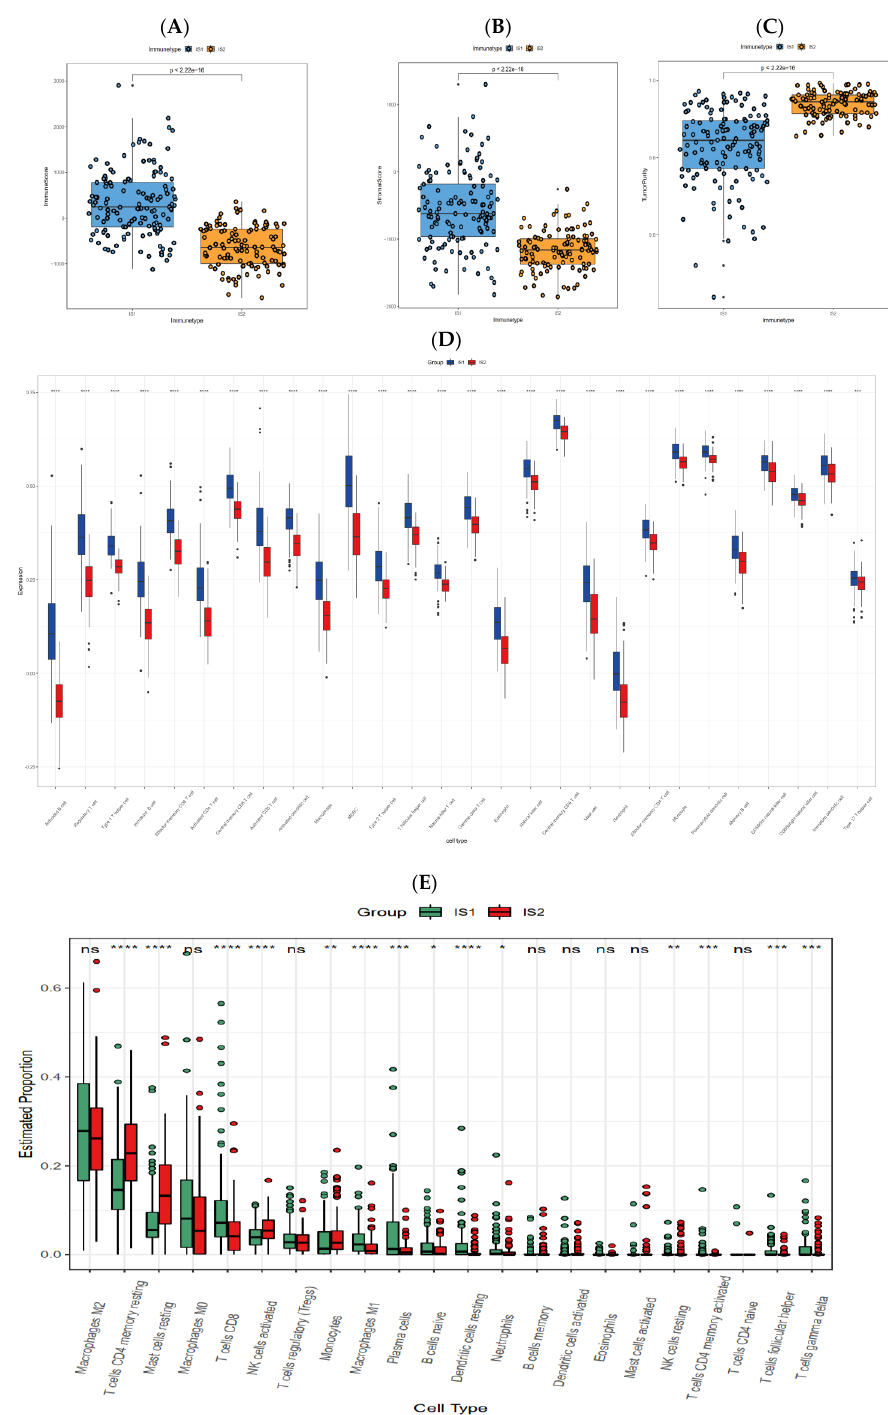
Figure 8. Analysis of the degree of immune cell infiltration in PRCC patients with different immune subtypes. ( A – C ) Immune score, stromal score and tumor purity of each sample were assessed by the ESTIMATE algorithm. ( D ) The immune cell infiltration pattern uncovered by the ssGSEA method. ( E ) Immune cell infiltration differences evaluated by CIBERSORT algorithm. * p < 0.01, ** p < 0.001, *** p < 0.0001, and **** p < 0.00001.